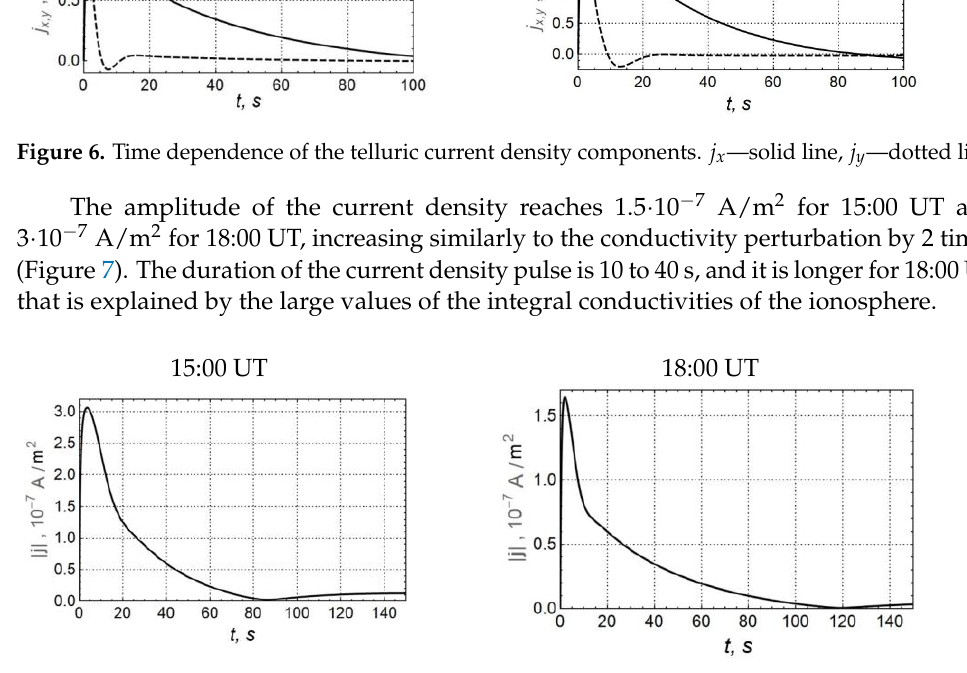
Figure 7. Time dependence of the modulus of the telluric current density vector.